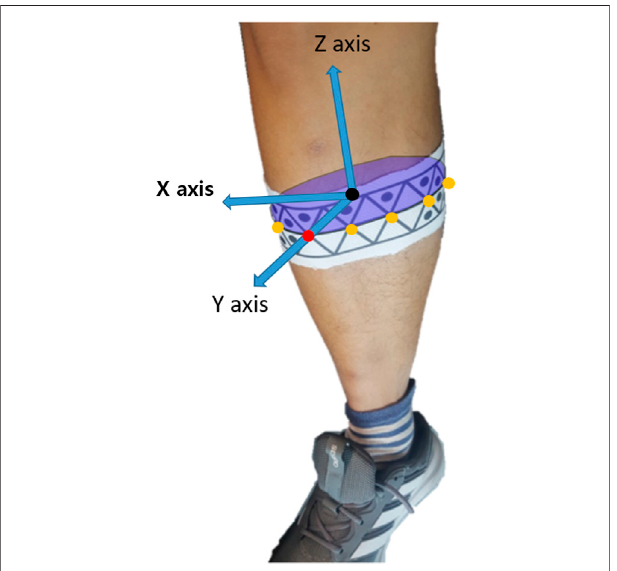
FIGURE 5 | Example of the pose estimation referencing system. Each body segment was de fi ned with respect to the anterior (positive Y axis) and proximal (positive Z axis) directions. The positive X axis corresponds to the cross product of Y and Z axes.